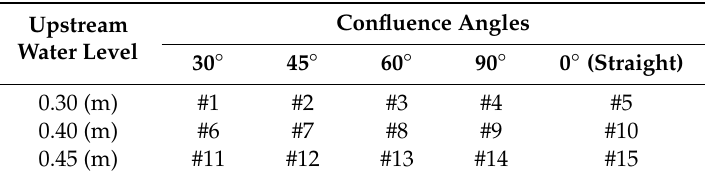
Table 1. Di ff erent test